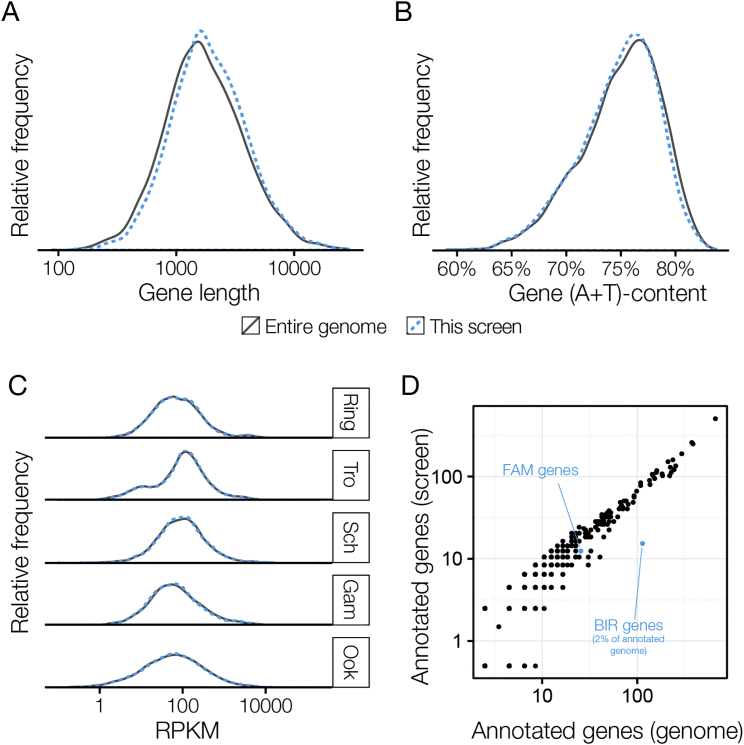
Genes in the Screen Are Largely Representative of the Genome, Related to Figure 1 and Table S2(A and B) Genes for which targeting vectors could be generated were similar (A) in size and (B) in A+T nucleotide content.(C) Targeted genes had expression levels representative of the genome across all life stages (RPKM data from Otto et al., 2014).(D) Relative representation of GO terms and multigene families in the genome and and the screen. The screen was largely representative with the exception of the P. berghei pir family (BIR) which we suspect is underrepresented due to its subtelomeric genomic location and repetitive nature. However, the well represented FAM family is shown for comparison.